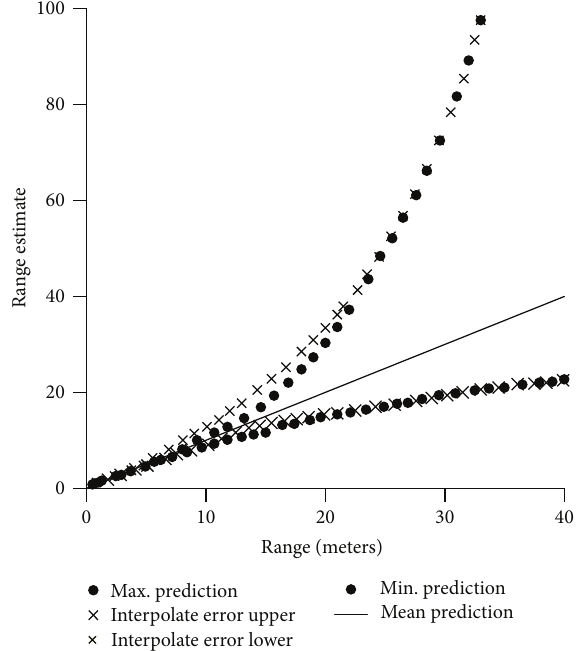
Figure11:Rangeerrorestimatesversusrangefordaylight.Thedash- es show maximum and minimum predictions versus range.